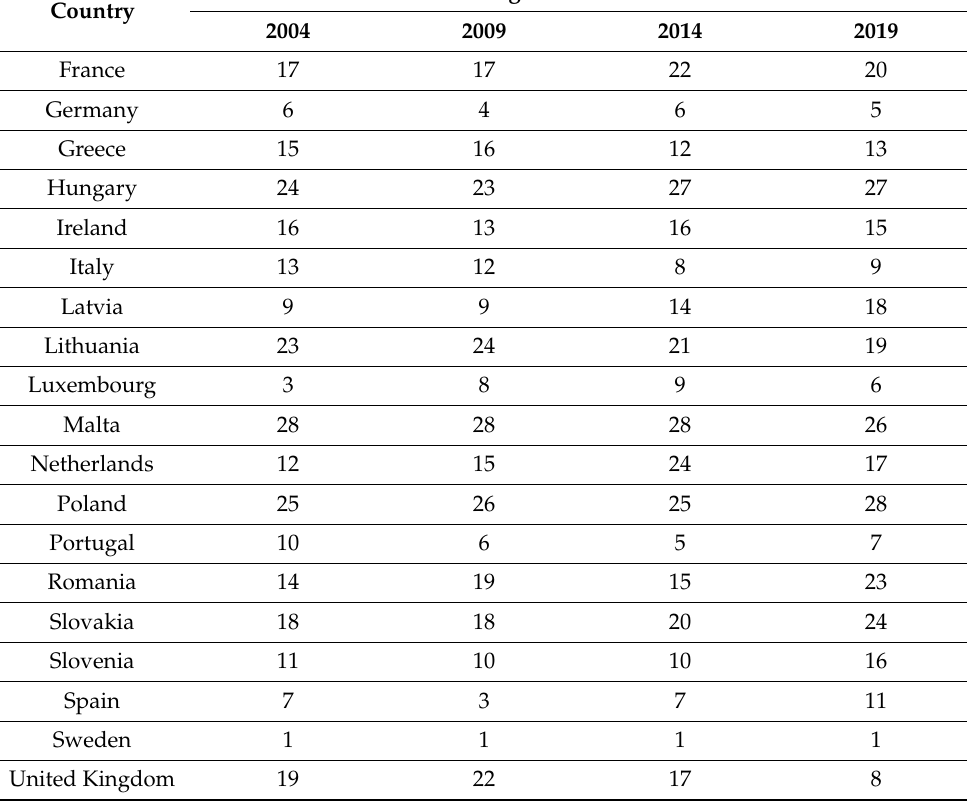
Ranking Position in the